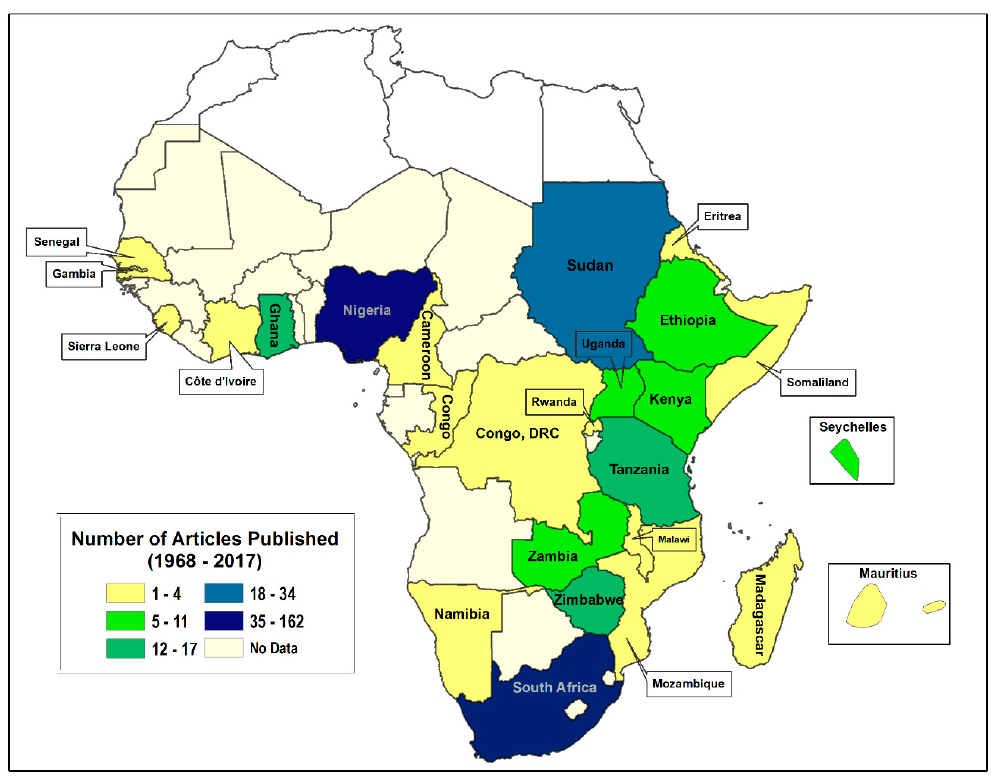
Figure 2. Distribution of peer-reviewed tobacco control publications in Sub-Saharan Africa (up to February 2017; n = 447).